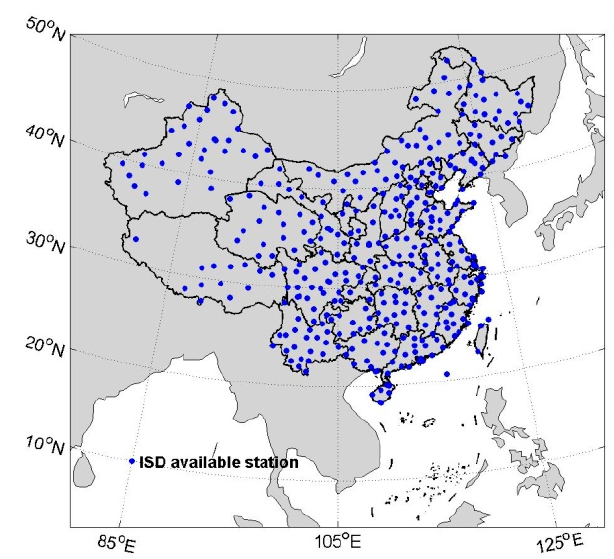
Figure 3. Distribution of ISD active stations over China in 2012.